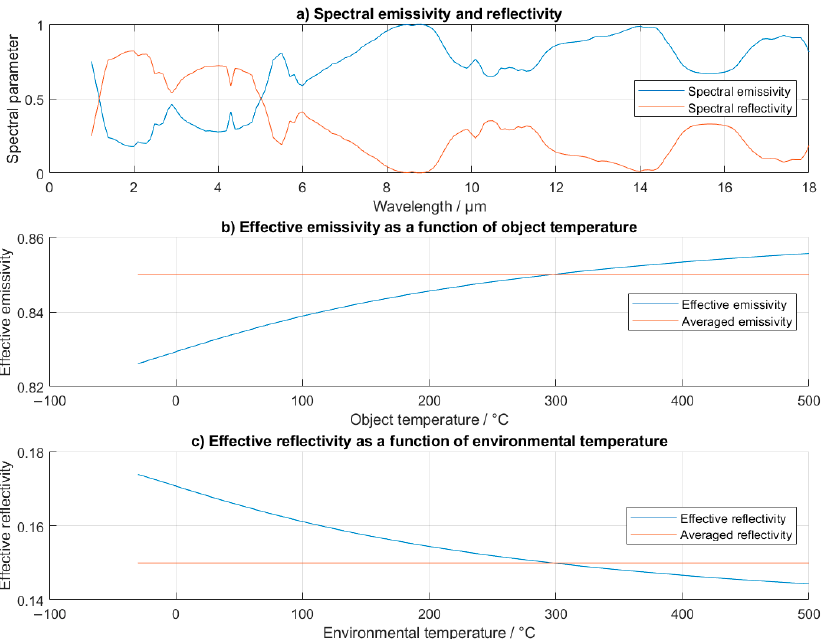
Figure 15. Shown are ( a ) the spectral emissivity and spectral re fl ectivity of the measured surface; ( b ) the spectrally averaged (8–14 µm) and e ff ective emissivity as a function of the temperature of the measured object; and ( c ) the spectrally averaged (8–14 µm) re fl ectivity and e ff ective re fl ectivity as a function of the environmental temperature, assuming pure emission according to Planck’s law,